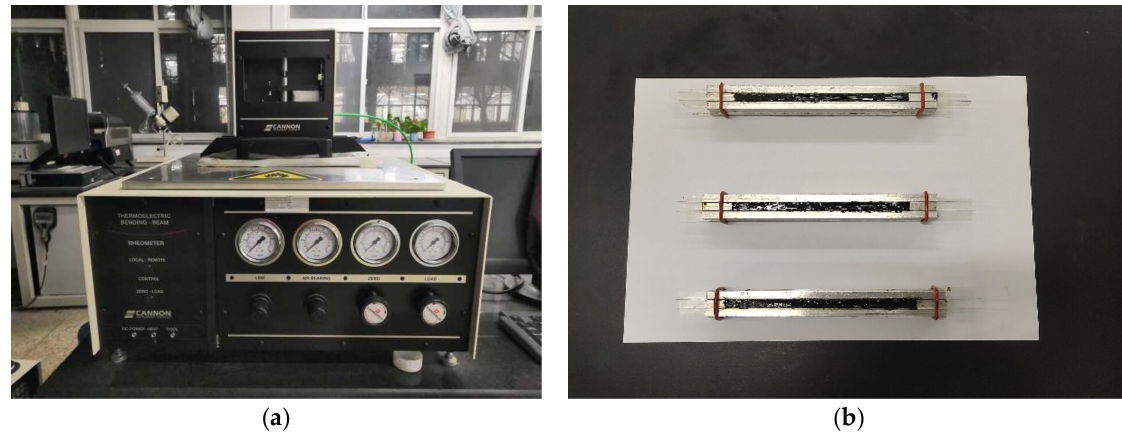
Figure 2. ( a ) Bending beam rheometer; ( b ) Asphalt test